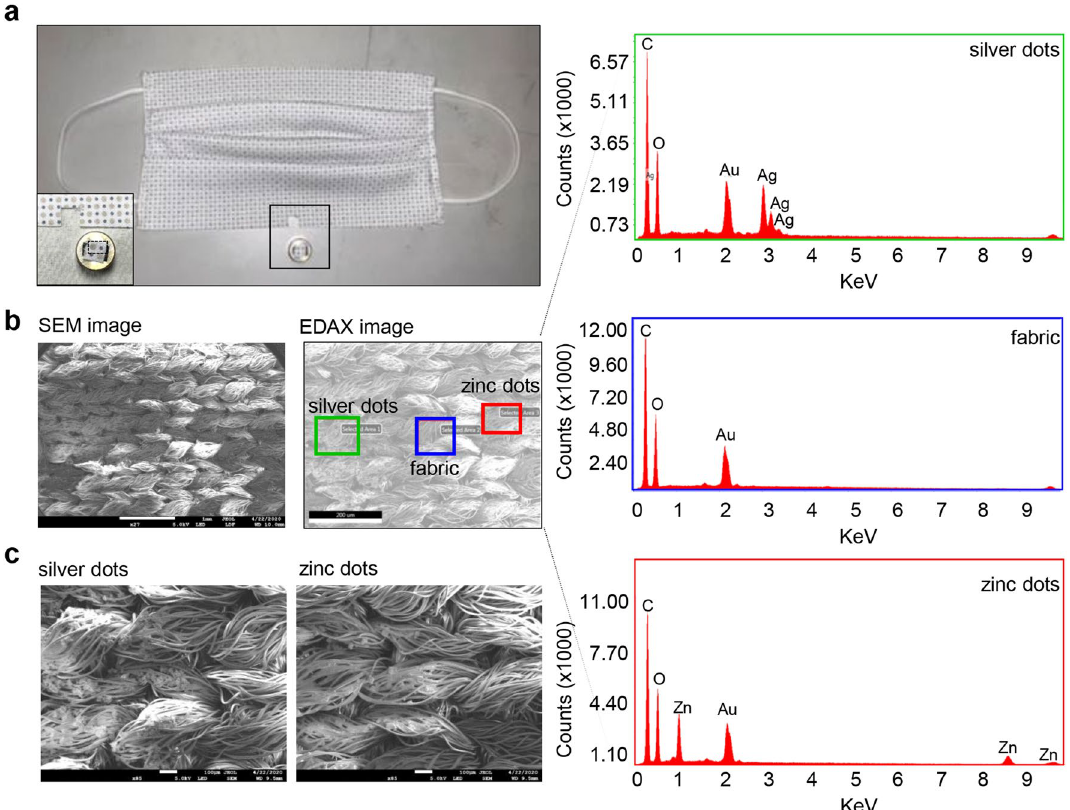
Figure 2. The prototype face mask utilizing stretchable electroceutical textile. ( a ) Photomicrograph of the region cut from the face mask and used for SEM and EDX analysis. ( b and c ) SEM and EDX analysis for silver and zinc deposition on the textile. Regions of mask used for EDX analysis have been marked and annotated in the respective figure